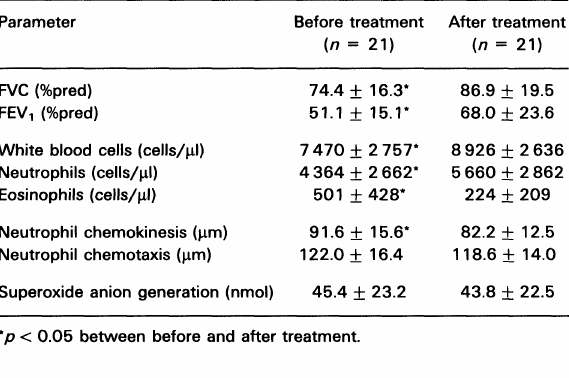
Table 2. Mean values (+ SD) of LTB4 release from whole blood and from isolated peripheral neutrophils in 21 asthmatic subjects, before and after treatment with systemic GCS Stimulus Before treatment After treatment (n 21) (n 21) Whole blood-LTB4 release (lg/ml) No stimulus